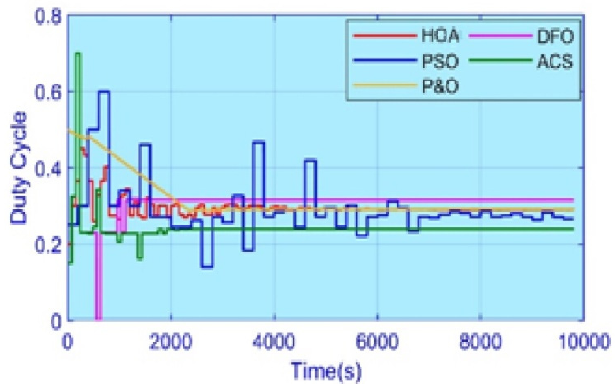
Figure 15. Comparison of HOA duty cycles for Case 2 .